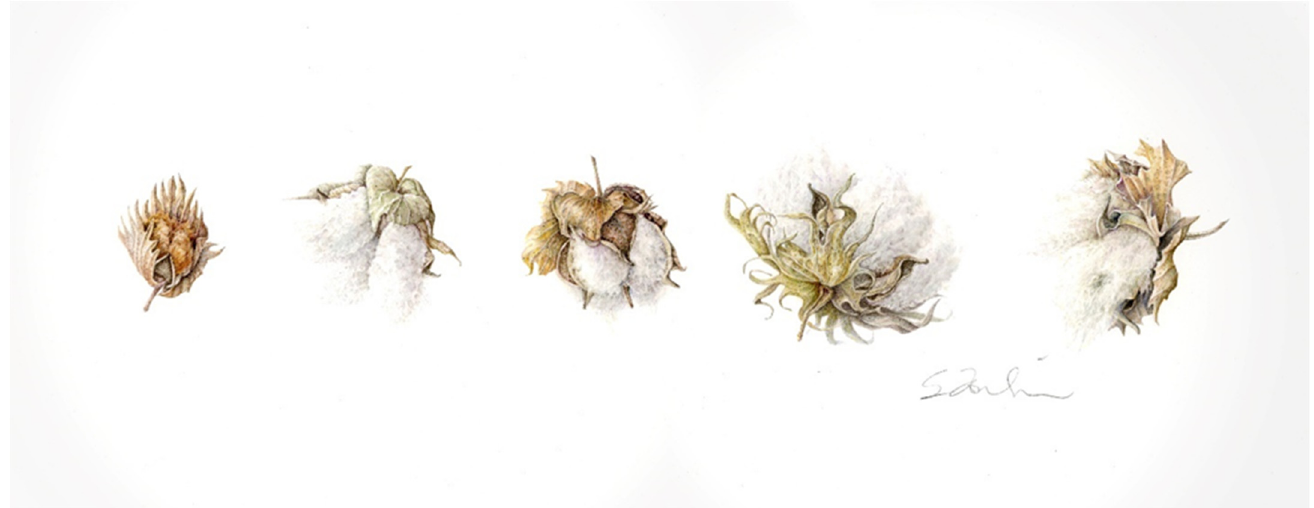
Figure 3. The Evolution of Cotton. Watercolor painting by Lubbock local artist Susan Tomlinson. From left to right: Gossypiodes kirkii, Gossypium arboreum, Gossypium herbaceum, Gossypium hirsutum, Gossypium barbadense. Watercolor on paper, 7 × 16 inches. ©2020 Susan